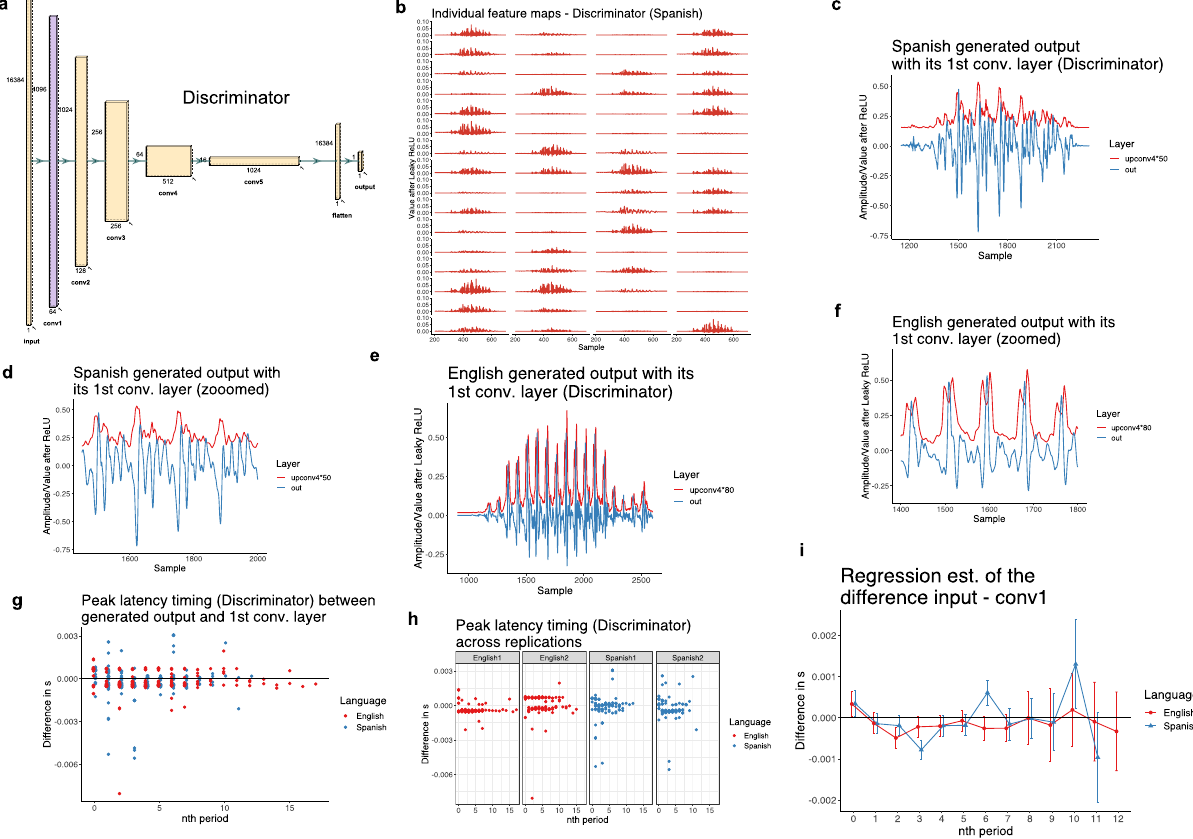
Figure 6. ( a ) The structure of the Discriminator network with five convolutional layers 66 . The first convolutional layer (Conv1) is color-coded with purple. ( b ) All 64 individual feature maps for a single input (the Generator’s forced output) from the first convolutional layer (Conv1) after Leaky ReLU. ( c ) One Spanish input (in blue) from the Generator’s forced output with the corresponding values from the first convolutional layer (Conv1) averaged over all feature maps. The plot illustrates peak latency between input and Conv1 for the burst and each vocalic period. ( d ) A zoomed version of (c) focusing on four vocalic periods. ( e ) One English input (in blue) from the Generator’s forced output with the corresponding values from the first convolutional layer (Conv1) averaged over all feature maps. The plot illustrates peak latency between input and Conv1 for the burst and each vocalic period. ( f ) A zoomed version of (e) focusing on five vocalic periods. ( g ) Raw peak latency timing (input peak time - Conv1 peak time) for burst (=0) and each nth vocalic period across the two conditions (English vs. Spanish). Periods above the 12th period are rare and are discarded from the statistical analysis due to a small number of attestations. The data is pooled across the two replications. ( h ) Raw peak latency timing across the replications (first and second replication) and two conditions (English and Spanish). ( i ) Linear regression estimates for the peak latency timing between the two conditions (English vs. Spanish). Periods above the 12th period are discarded from the analysis due to a small number of attestations. The data is pooled across the two